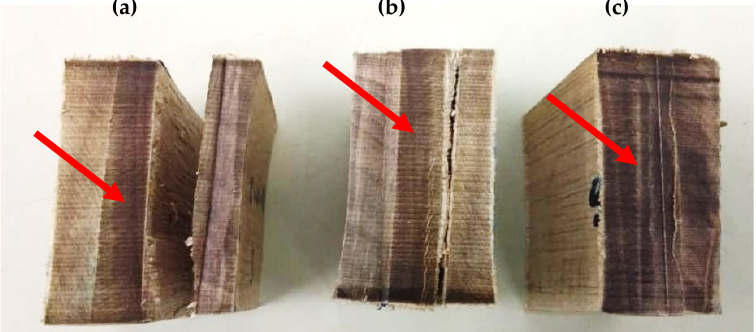
Figure 5. Coefficient correlation between the shear strength and fiber pore areas of the untreated and treated Paraserianthes falcataria glulam.